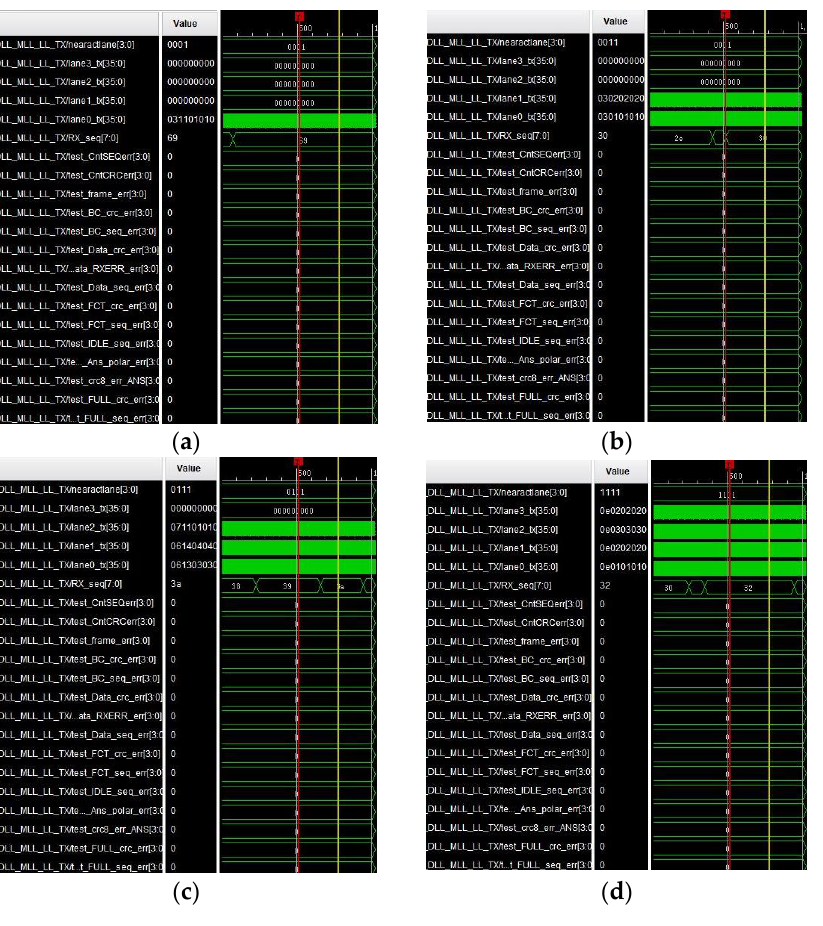
Figure 9. The ILA waveforms of full-duplex communication with M active lanes. ( a ) M = 1; ( b ) M = 2; ( c ) M = 3; ( d ) M = 4.